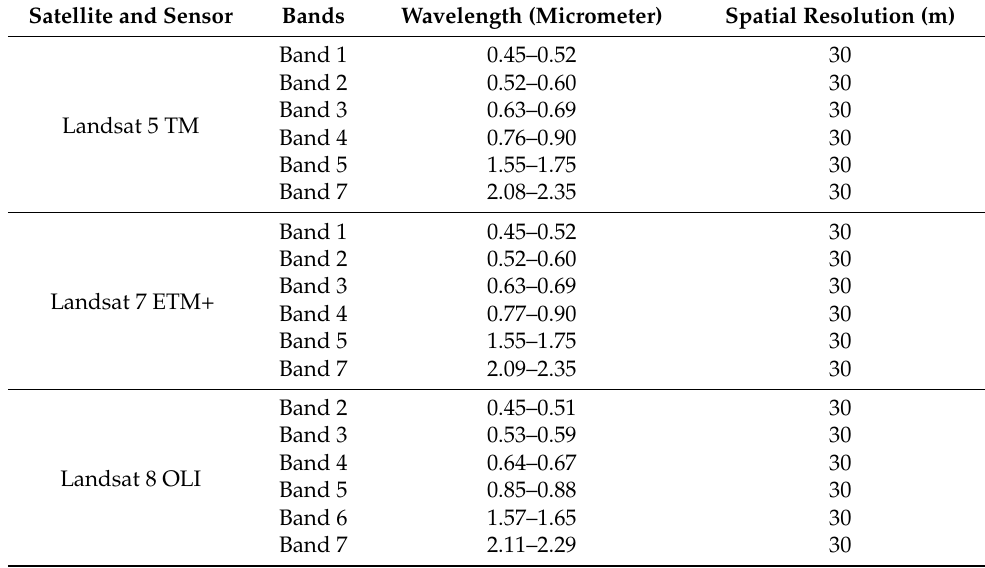
Table A2. The bands of Landsat 5, 7, and 8 data used to compute the vegetation and mangrove indices. Satellite and